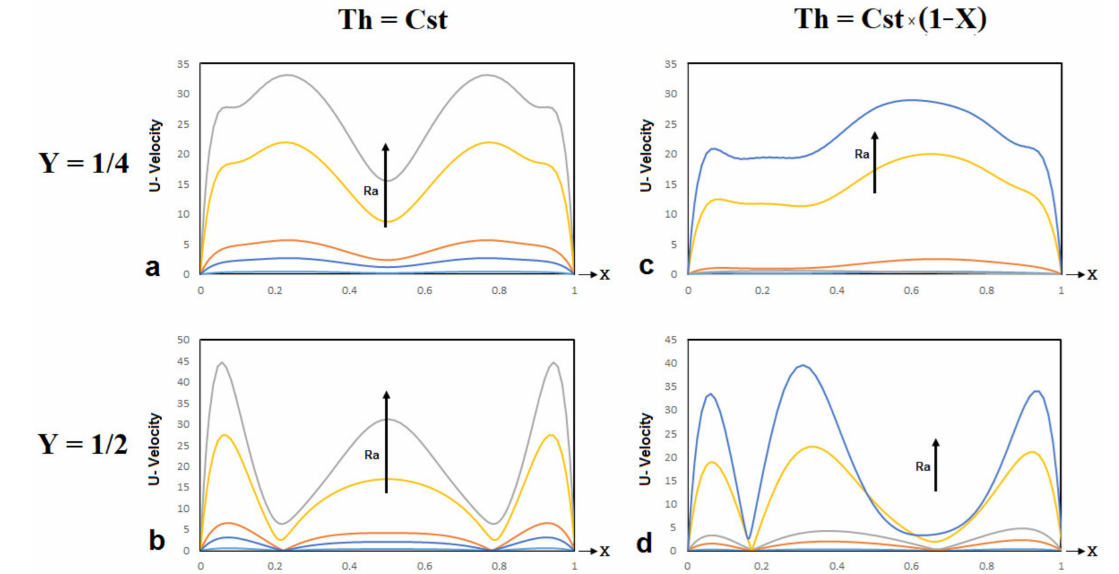
Figure 6. Combined effects of hot temperature distribution and Rayleigh number on nanofluid veloc- ity magnitude evolutions along x -axis: ( a ) Imposed hot temperature Th = Cst and Level Y = 1/4; ( b ) Im- posed hot temperature Th = Cst and Level Y = 1/2; ( c ) Imposed hot temperature Th = Cst × (1 − X)